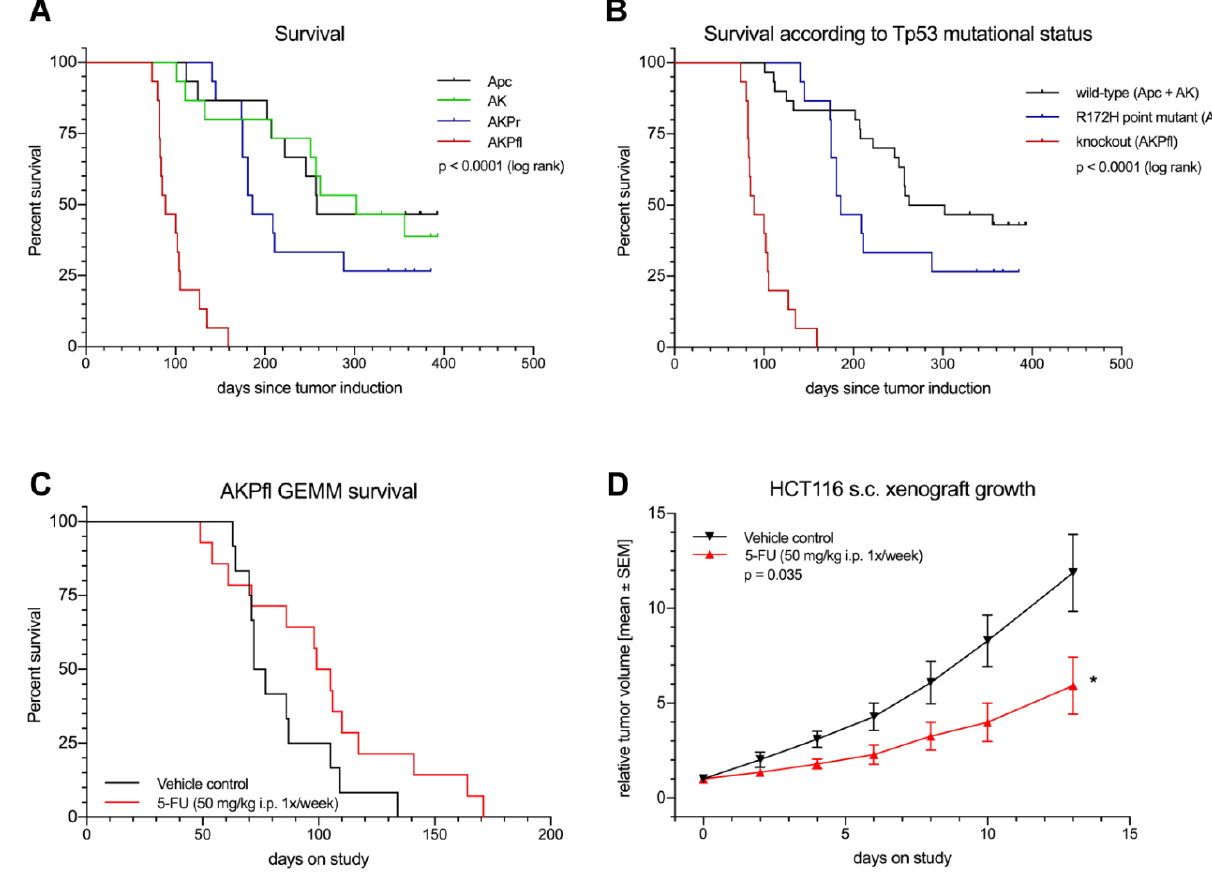
Figure 4. The GEMM mimics the survival and treatment response of human CRC more accurately than a xenograft model. ( A ) Survival of the GEMM depending on the genotype. ( B ) Influence of TP53 mutational status on survival in the CRC GEMM. ( C , D ) Treatment experiments. ( C ) Kaplan–Meyer survival curves of AKPfl mice treated with 5-FU (50 mg/kg i.p the same regimen. * p < 0.05. Apc, Apc fl/fl mice; AK, Apc fl/fl /Kras LSL-G12D/+ mice; AKPr, Apc fl/fl /Kras LSL-G12D/+ /Trp53 LSL-R172H/+ mice; AKPfl, Apc fl/fl /Kras LSL-G12D/+ /Trp53 fl /fl mice. * p < 0.05